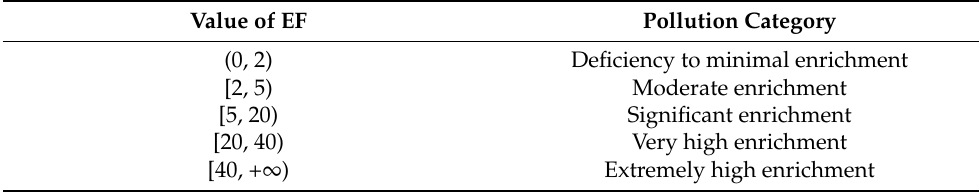
Table 1. The value of EF and the pollution category.